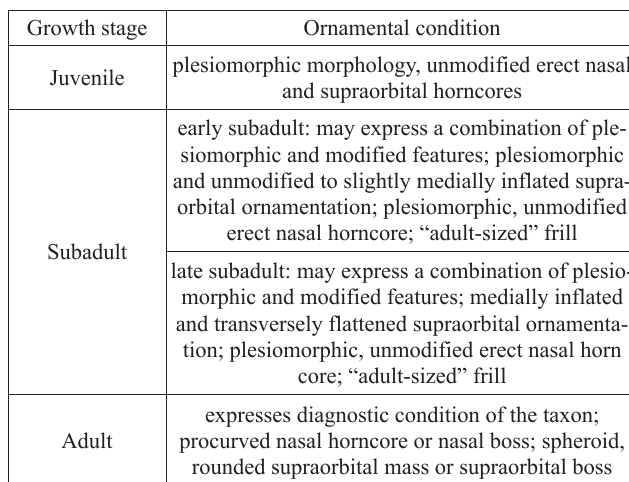
Table 2. Ontogenetic development and ornamental expression of Einio­ saurus procurvicornis and Achelousaurus horneri growth stages. Or- namental expression is based on articulated skulls of subadults